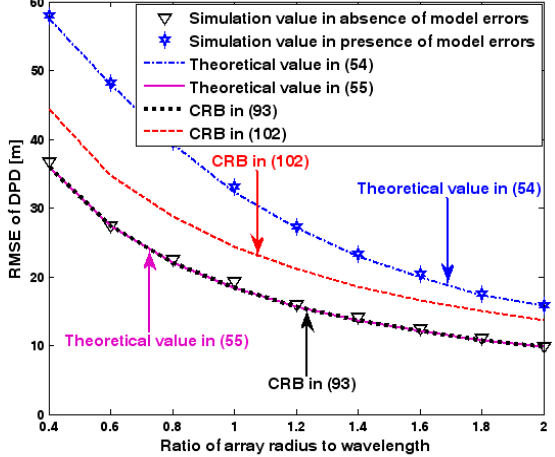
Sensors 2017 , 17 , 1550 Figure 10. RMSE of DPD as a function of number of array elements. Figure 10. RMSE of DPD as a function of number of array elements. Figure 10. RMSE of DPD as a function of number of array elements.